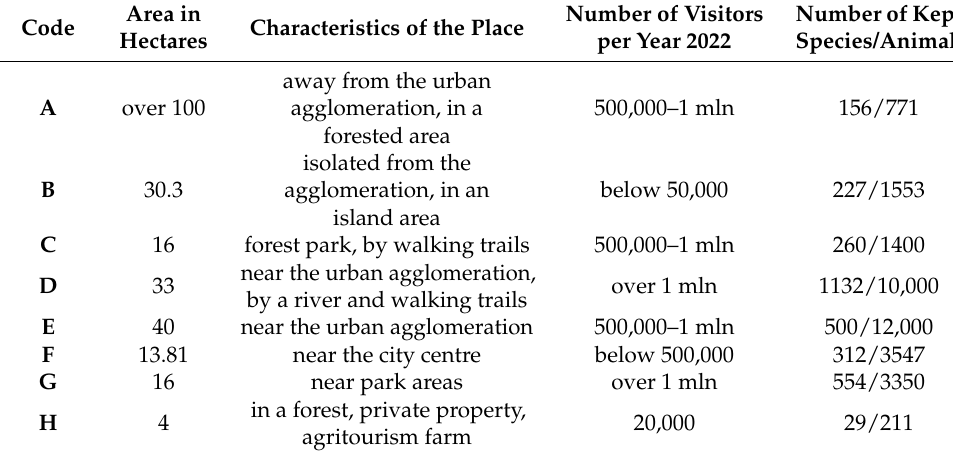
Table 1. Characteristics of the zoos in which material was collected